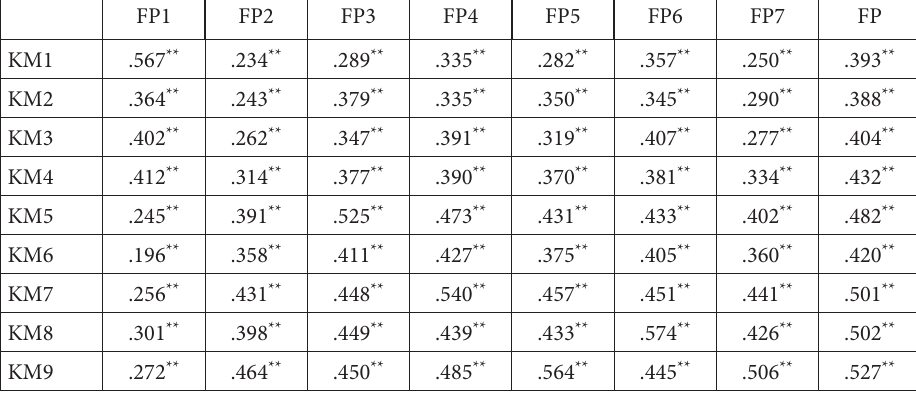
Table 1. Correlation coefficients between the dimensions of knowledge management and the dimen- sions of financial performance (items) and the financial performance as a dimension FP1 FP2